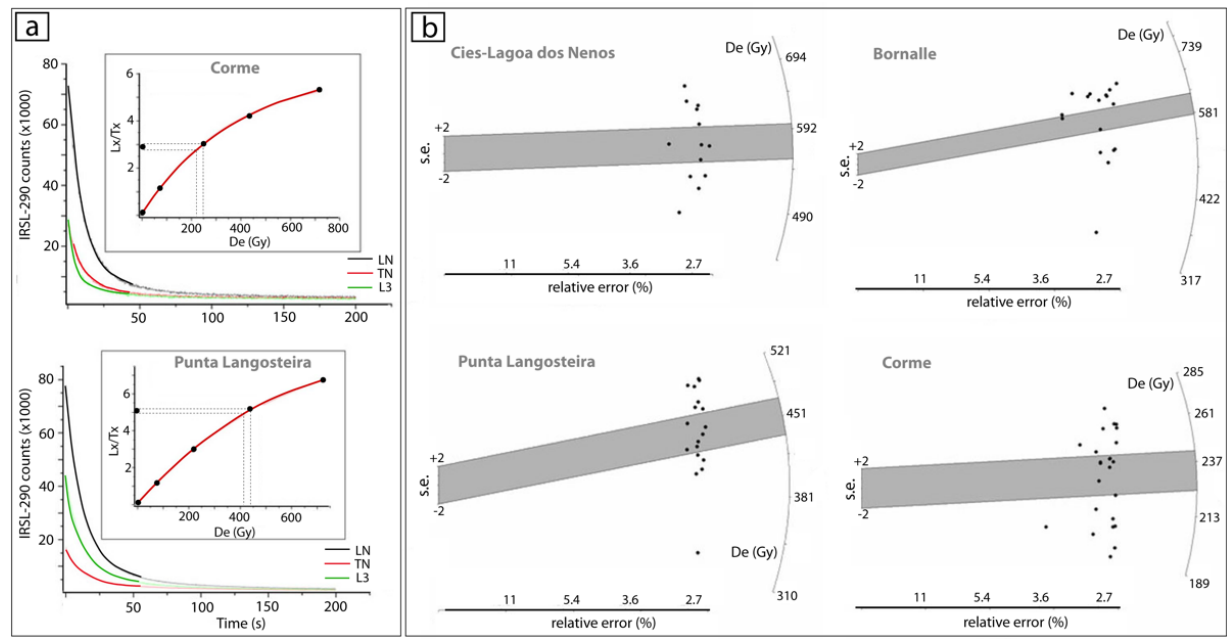
Figure 4. IRSL signal from feldspars and D e s distribution . ( a ) Some examples of the fast decay curves